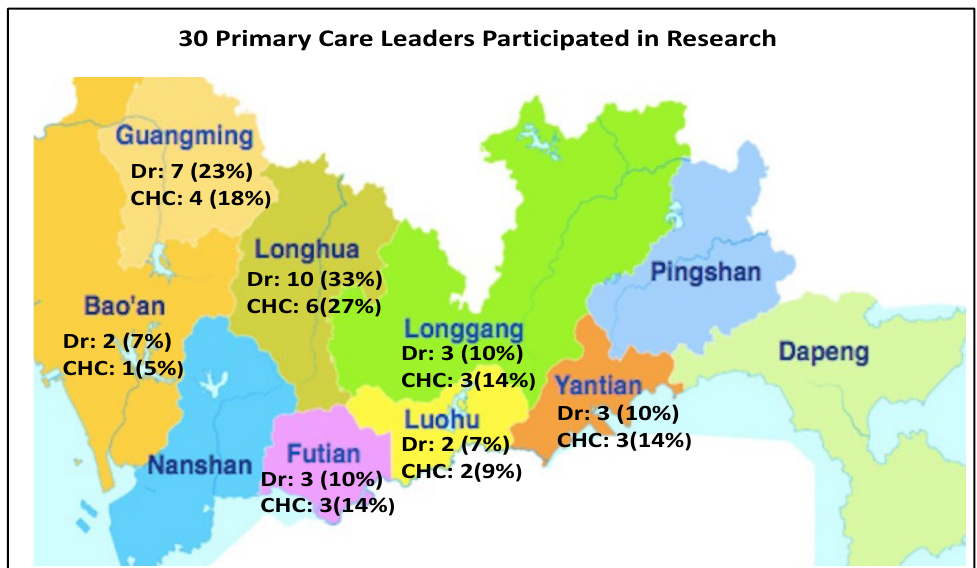
Figure 1. Geographic distribution of participants and community healthcare centres.